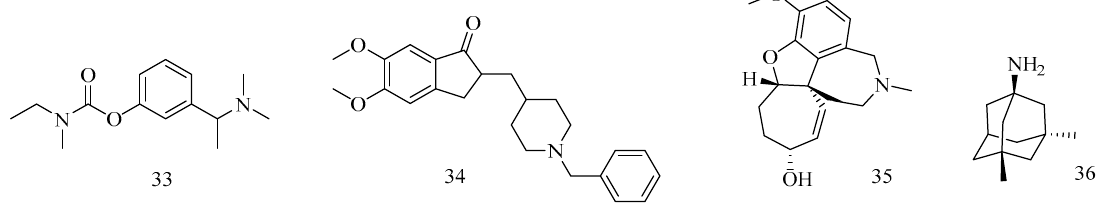
Figure 10. Currently approved drugs for treatment of Alzheimer’s disease